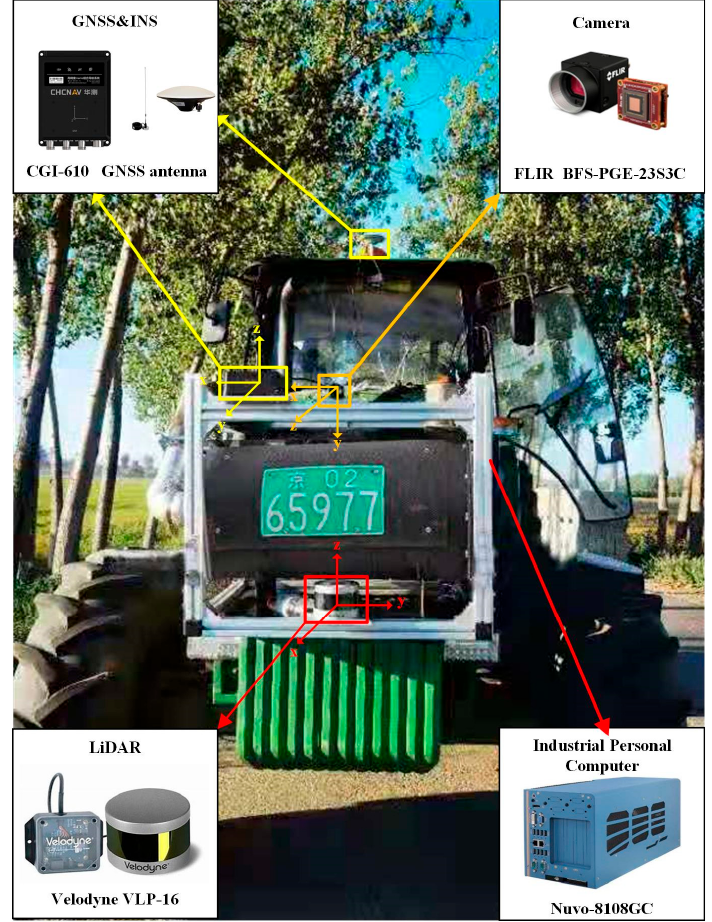
Figure 1. Installation diagram of data acquisition system.